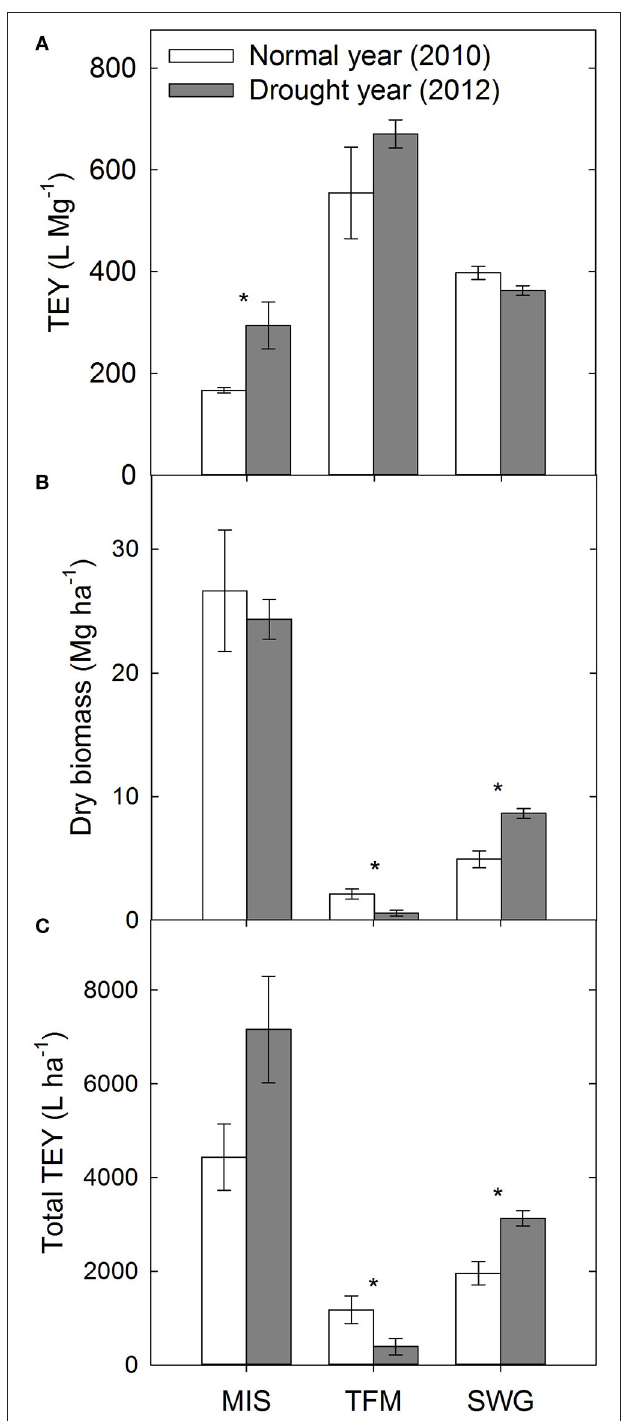
FIGURE 2 | Theoretical ethanol yield (TEY) based on enzymatic hydrolysis glucose yields (A) , dry biomass yield (B) , and total TEY per hectare of dry biomass (C) for Miscanthus (MIS), a tall fescue mixture (TFM), and switchgrass (SWG) grown during a normal year (2010) and a drought year (2012). Asterisks indicate significant differences from a one-way, repeated measures ANOVA comparing 2010 with 2012 for each feedstock separately ( p ≤